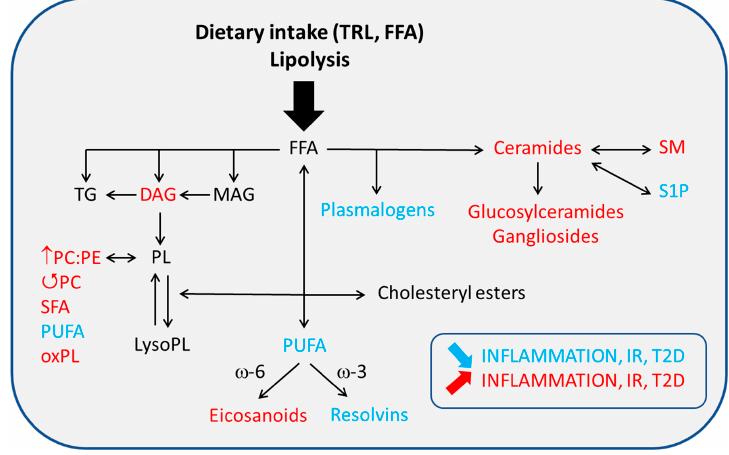
Figure 2. Fate of fatty acids in adipose tissue macrophages. The association of fatty acid (FA)-derived lipids with inflammation, IR and T2D is indicated in blue (protective) or red (deleterious). DAG, diacylglycerol; FFA, free fatty acids; IR, insulin resistance; MAG, monoacylglycerol; oxPL, oxidized PL; PC, phosphatidylcholine; PE, phosphatidylethanolamine; PL, phospholipid; PUFA, polyunsaturated fatty acid; S1P, sphingosine-1-phosphate; SFA, saturated fatty acid; SM, sphingomyelin; T2D, type 2 diabetes; TG, triacylglycerol; TRL, triglyceride-rich lipoproteins;